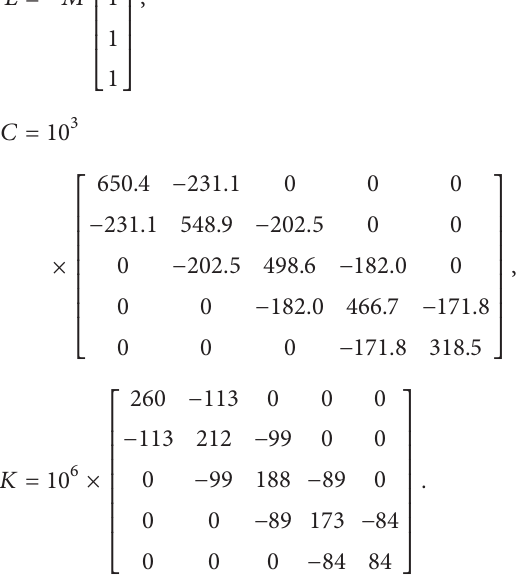
The expected amounts for each component of the error vector are